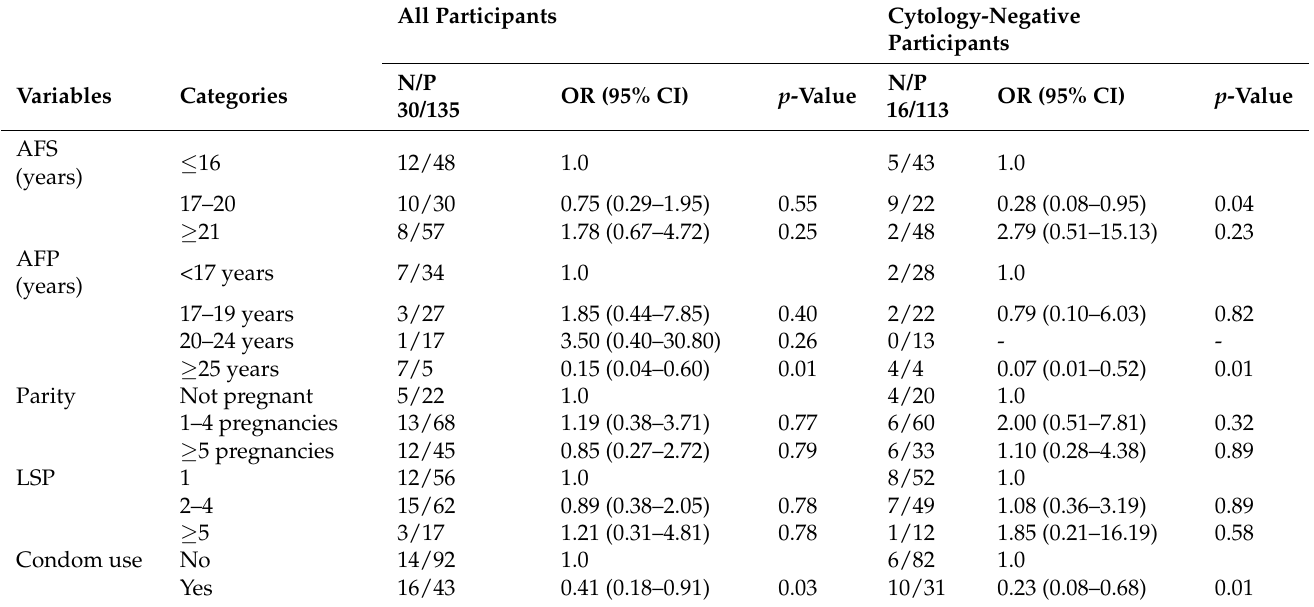
Table 2. Odds ratios of HPV positivity according to sex-behavior-related variables.